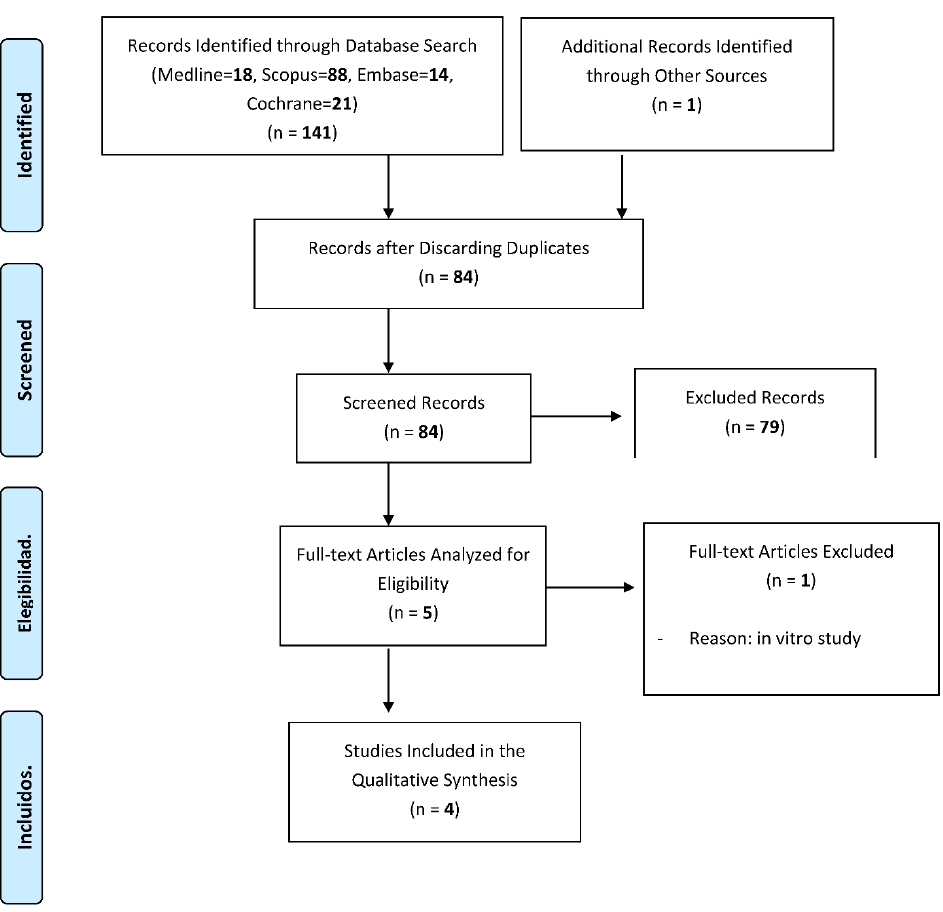
Figure 1. A flowchart giving a detailed overview of the study selection process.